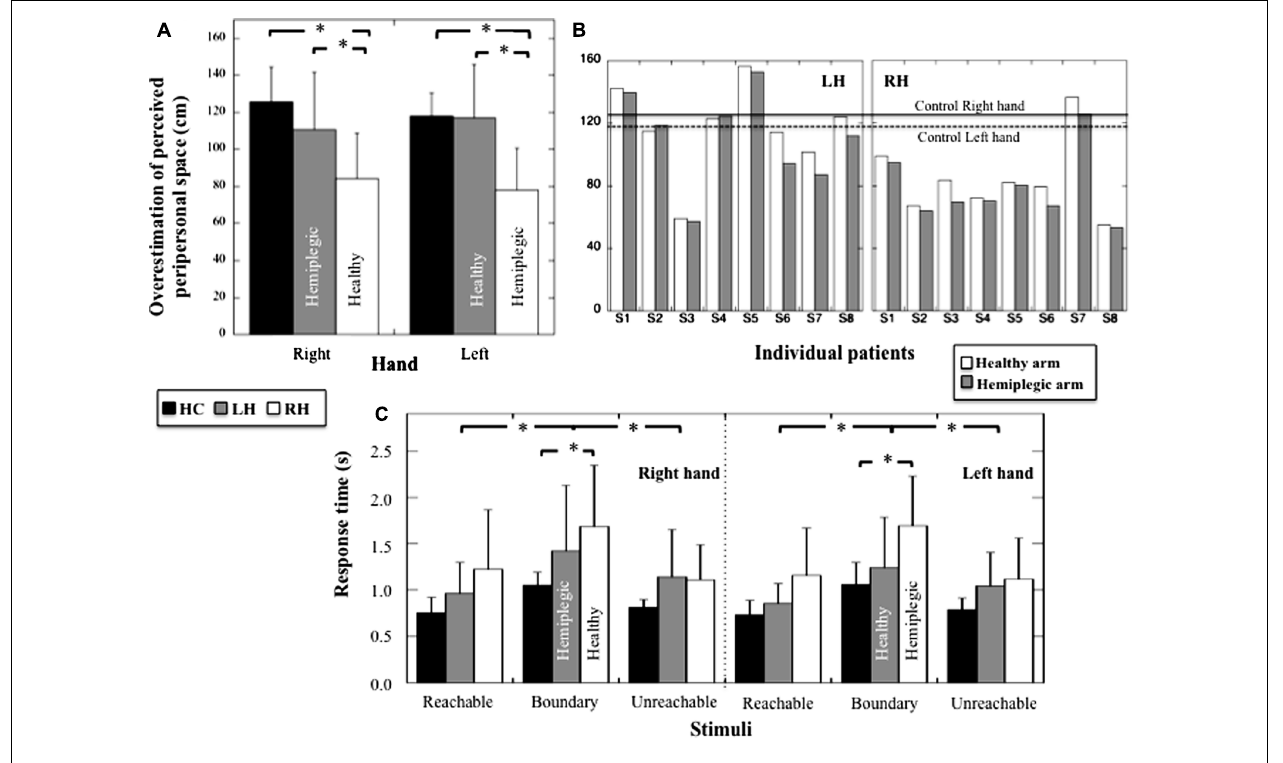
left hand for HC are also indicated. (C) Mean response times (and SD, in seconds) for the stimuli judged reachable, unreachable, or at the boundary or reachable space for HC, LH, and RH and for judgments provided according to the right or the left hand. Stars indicate significant statistical